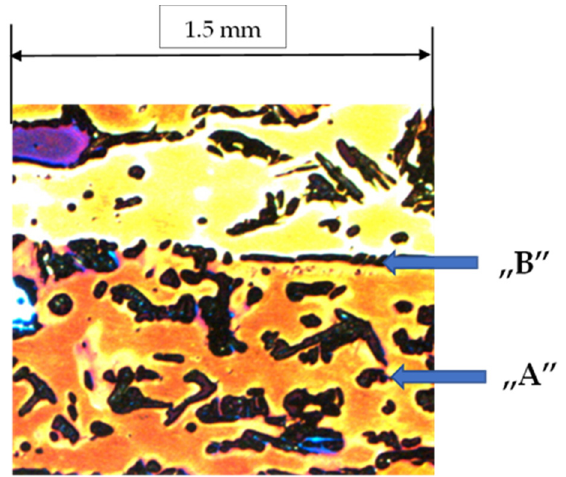
Figure 9. Two types of degenerated eutectic in the resolidified initial mushy zone sample